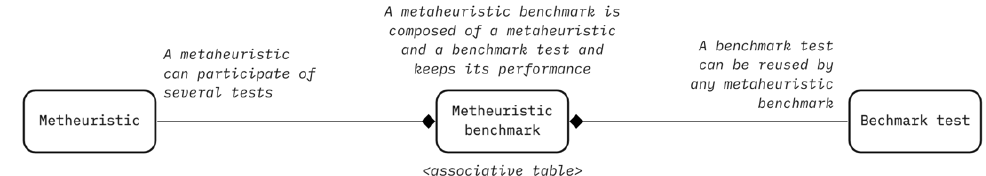
Figure 6. Basic relationship between metaheuristic and benchmark test.